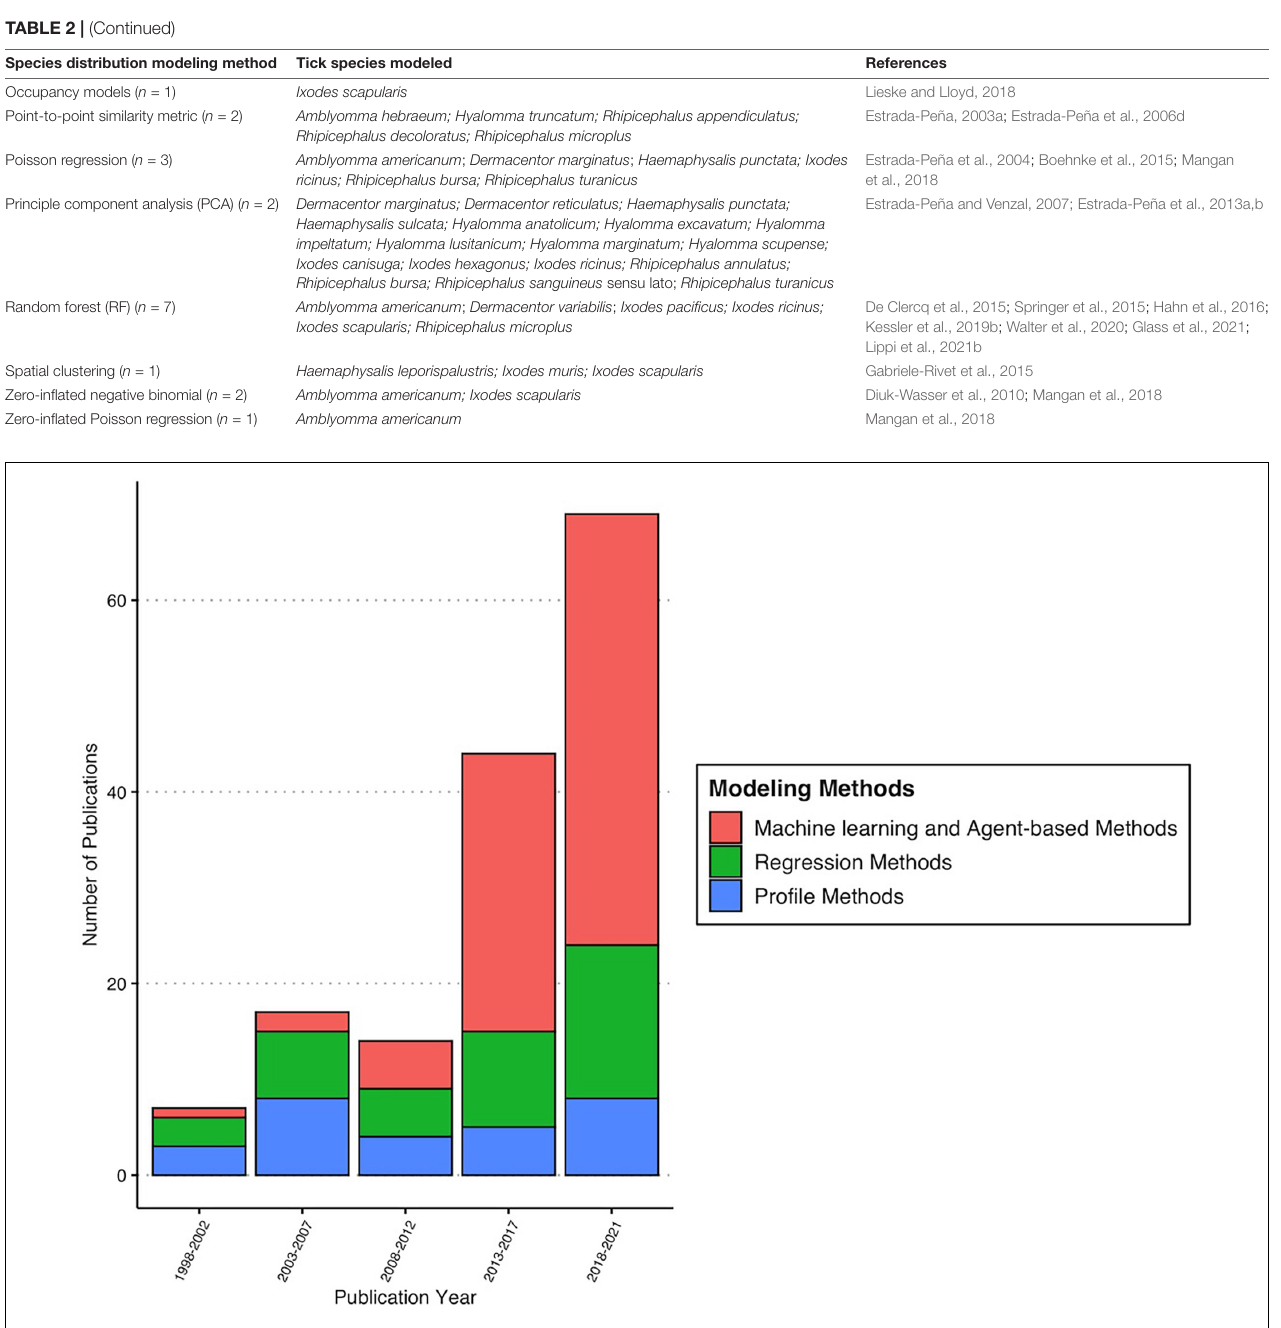
FIGURE 5 | Tick distribution modeling methods* used in included literature over time. *Machine learning/agent-based methods include MaxEnt, genetic algorithm for rule-set prediction, agent-based modeling, boosted regression trees, random forest, and classification and regression trees. Profile methods include DOMAIN procedure, ecological niche factor analysis, bioclimatic envelope model, Cokriging, principal component analysis, ANCOVA, climate response model (CLIMEX), correspondence analysis, Gower metric, joint distribution modeling, linear discriminant analysis, mixture discriminant analysis, multi-criteria decision analysis, minimum convex polygon, occupancy models, point-to-point similarity metric, spatial clustering, and Fourier analysis. Regression methods include generalized linear models, generalized additive models, multivariate adaptive regression splines, mixed effect logistic regression, negative binomial regression, Poisson regression, zero-inflated Poisson regression, and zero-inflated negative binomial